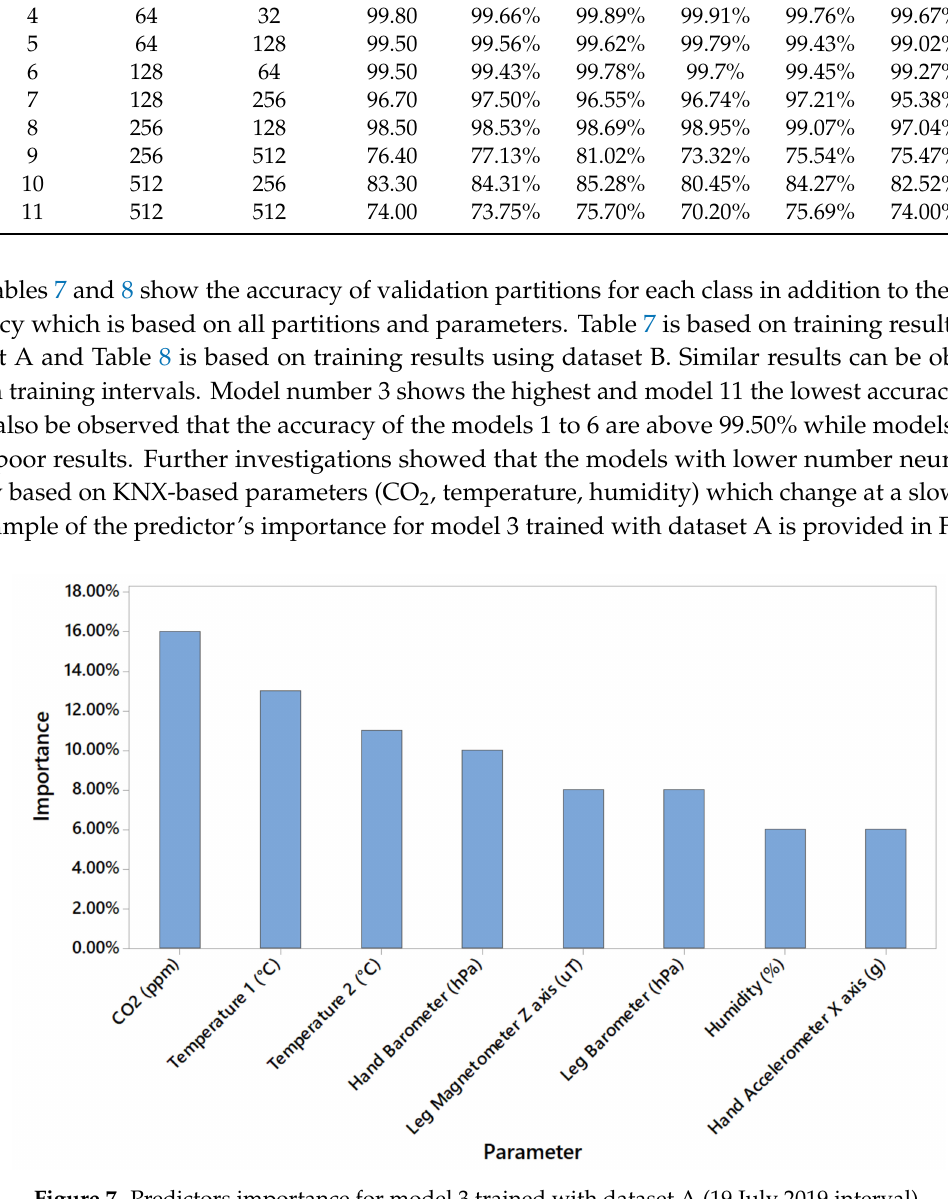
Figure 7. Predictors importance for model 3 trained with dataset A (19 July 2019